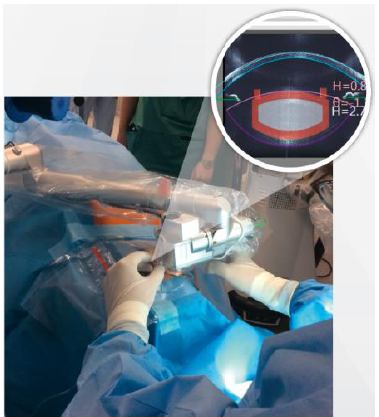
Figure 2. Femtosecond laser handpiece of the LDV Z8.